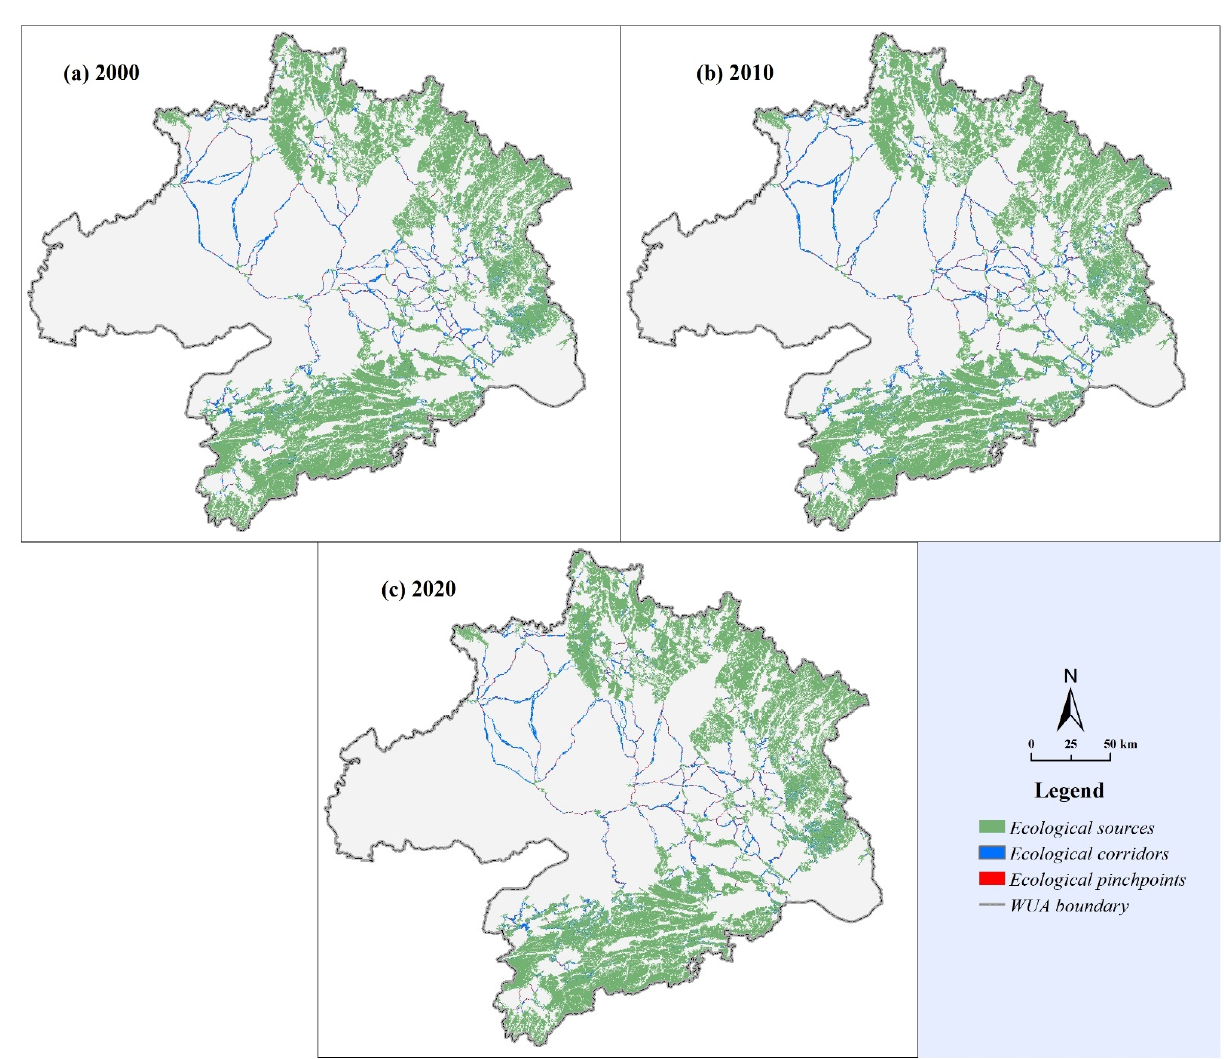
Figure 7. Spatial distribution of ecological pinchpoints in 2000, 2010, and 2020.